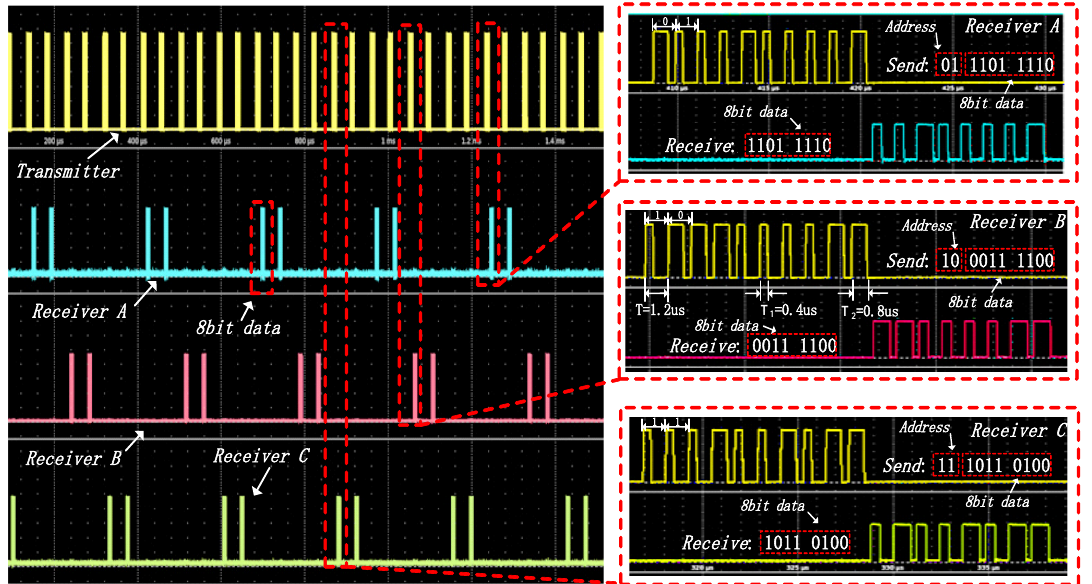
Figure 12. Test waveform of free-space optical communication system with point-to-multipoint.